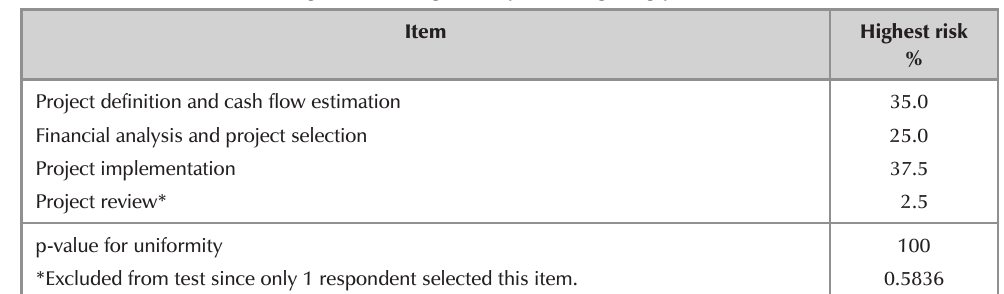
Highest risk stage in capital budgeting process Item